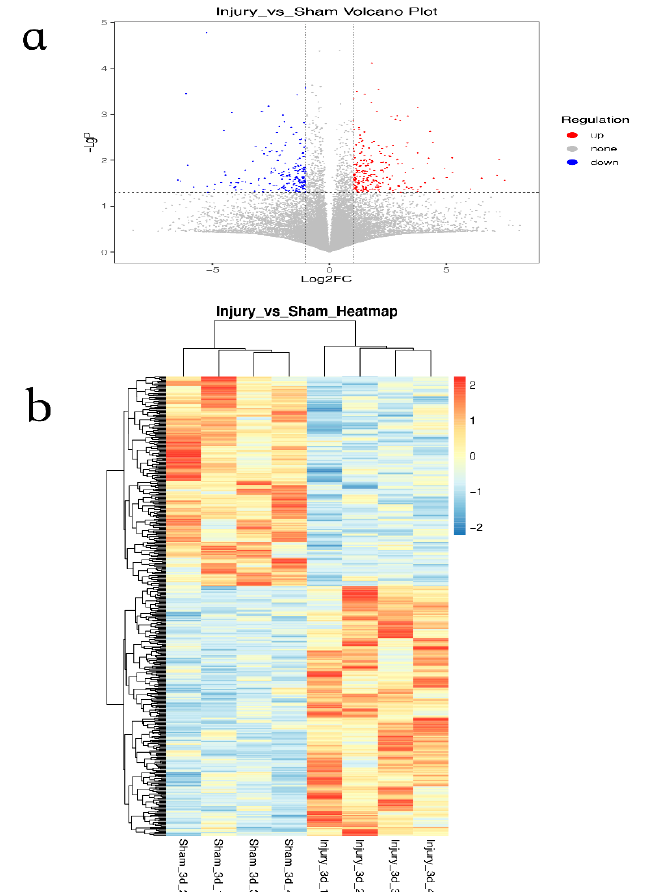
Figure 1. Identification of differentially expressed genes (DEGs) in GSE120284. ( a ) A volcano plot (Red: upregulated DEGs, Blue: downregulated DEGs); ( b ) Pearson correlation clustering heat map.